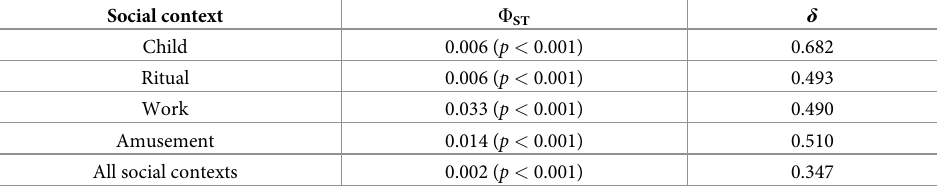
Table 2. F ST and δ values among the five regions of the Ryukyu Archipelago (Amami, Okinawa, Miyako, Yaeyama, and Yonaguni regions) for songs associated with each social context.